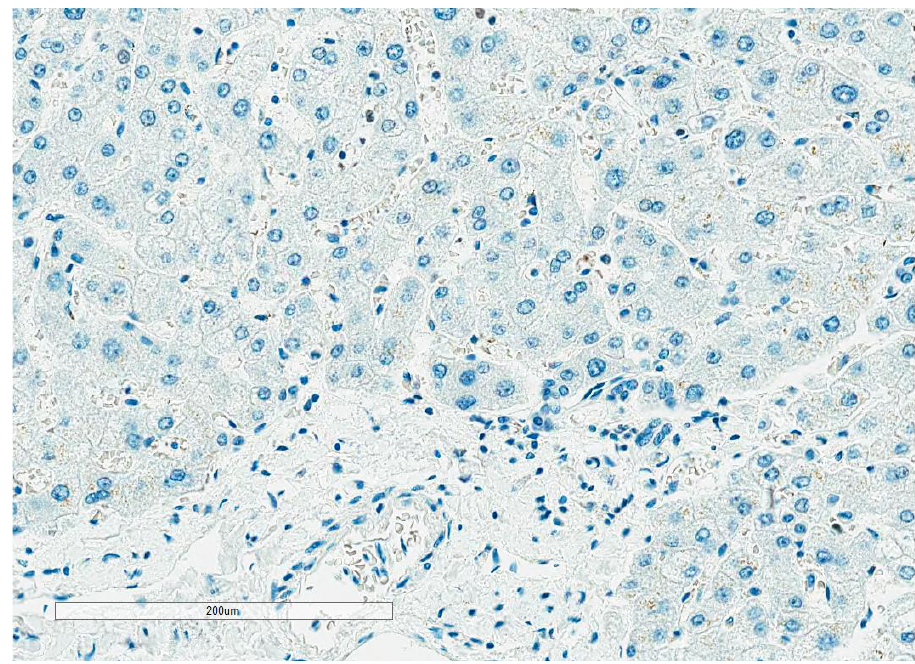
Figure B. Liver as Ki67 external negative control. Figure B illustrates the liver as Ki67 external neg- ative